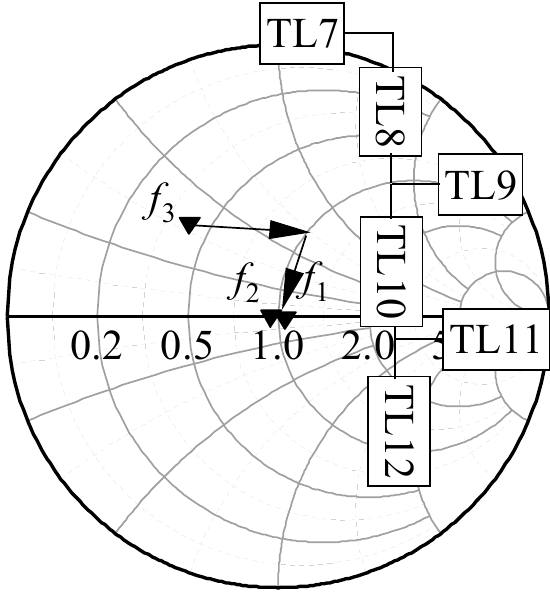
Figure 4. The matching circuit for the third frequency band.